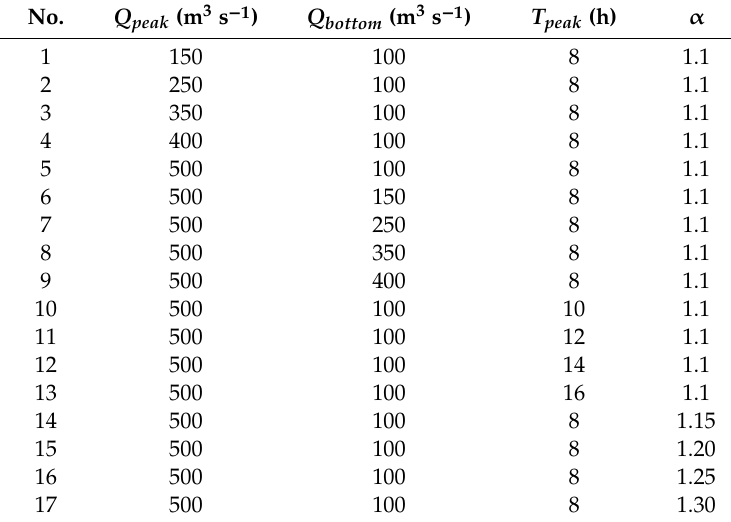
Table 1. Characteristics of each numerical experiment for identification of the influence of